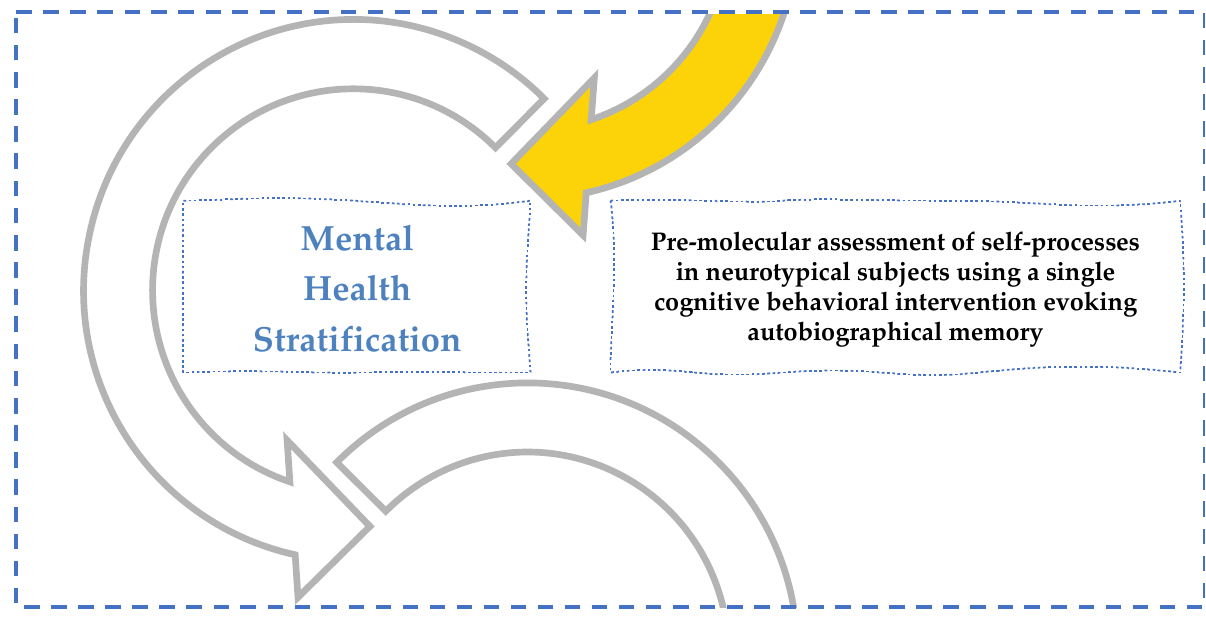
Figure 11. Research Outline: Mental Health Stratification Graphical scheme presenting the integration of this paper in the overall experiment conducted by the authors for mental health stratification of a neurotypical sample. “Pre-molecular assessment of self-processes in neurotypical subjects using a single cognitive behavioral intervention evoking autobiographical memory” comprehends thus the intervention and assessment protocols used in 128 healthy university students.